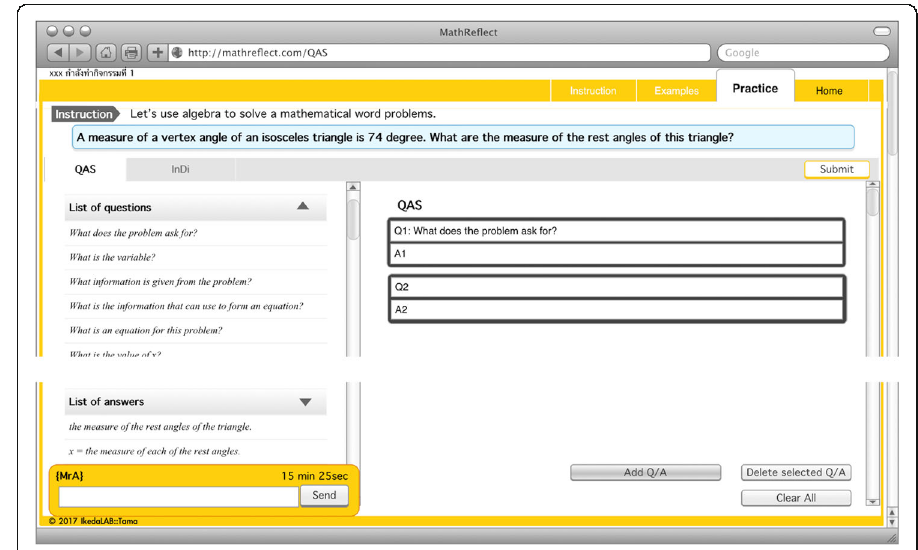
Fig. 7 Web interface of MathReflect at QAS constructing